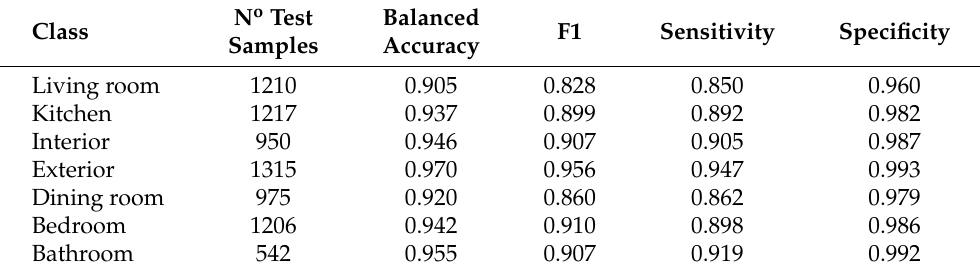
Table 1. The performance of stage on the test set separated by the room